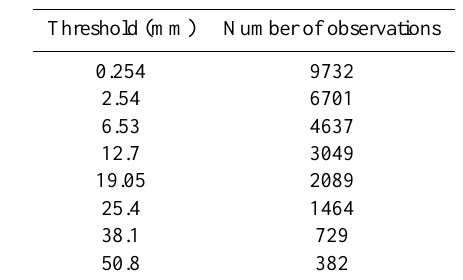
Table 2. Number of observations that go into calculations of bias and ETS